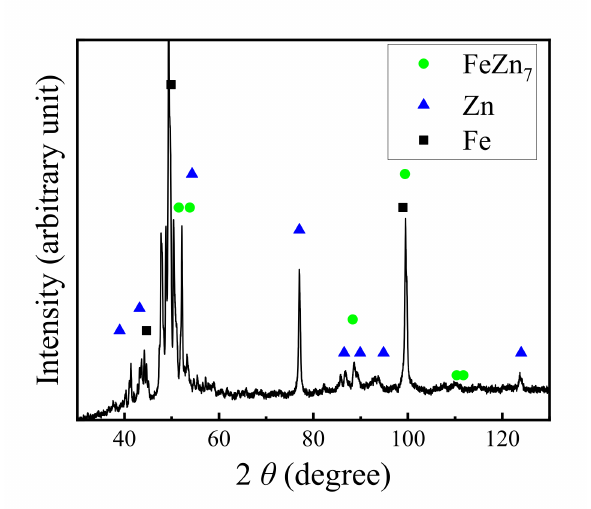
Figure 1. XRD analysis results for the surface of GA980.